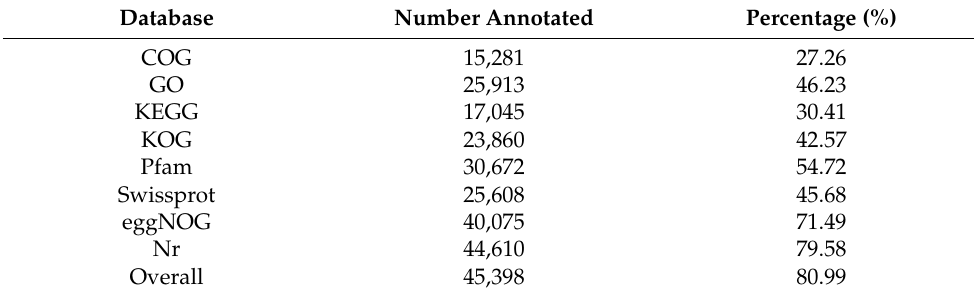
Table 2. Functional annotation of